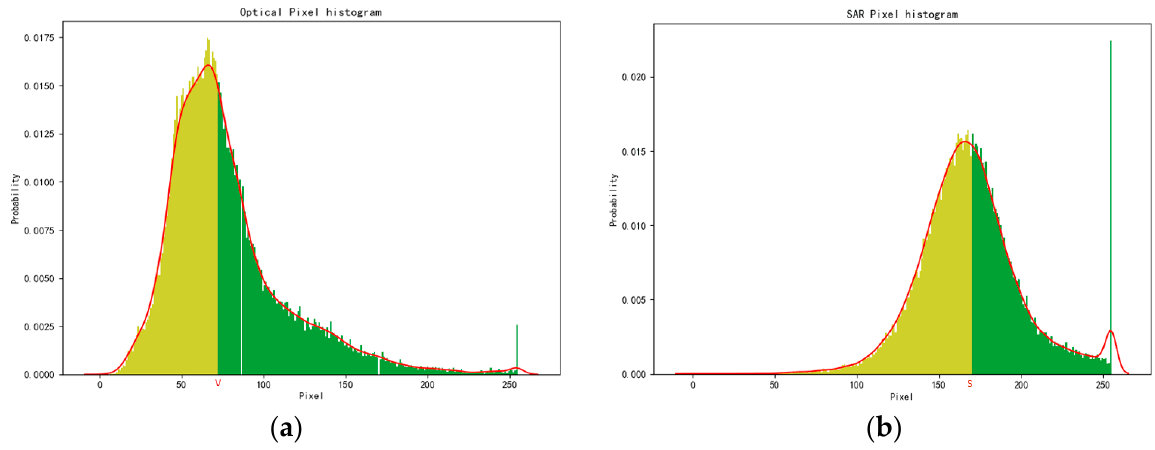
Figure 5. Pixel normalization method. ( a ) Optical pixel histogram; ( b ) SAR pixel histogram.